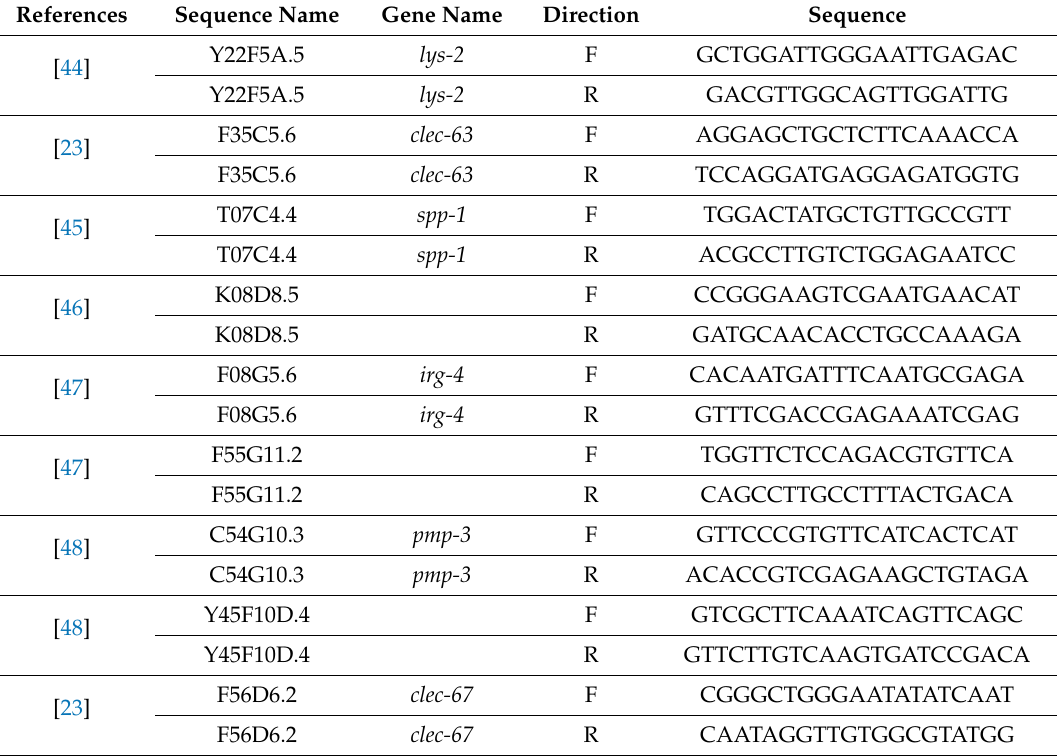
Table 1. qPCR primer list.